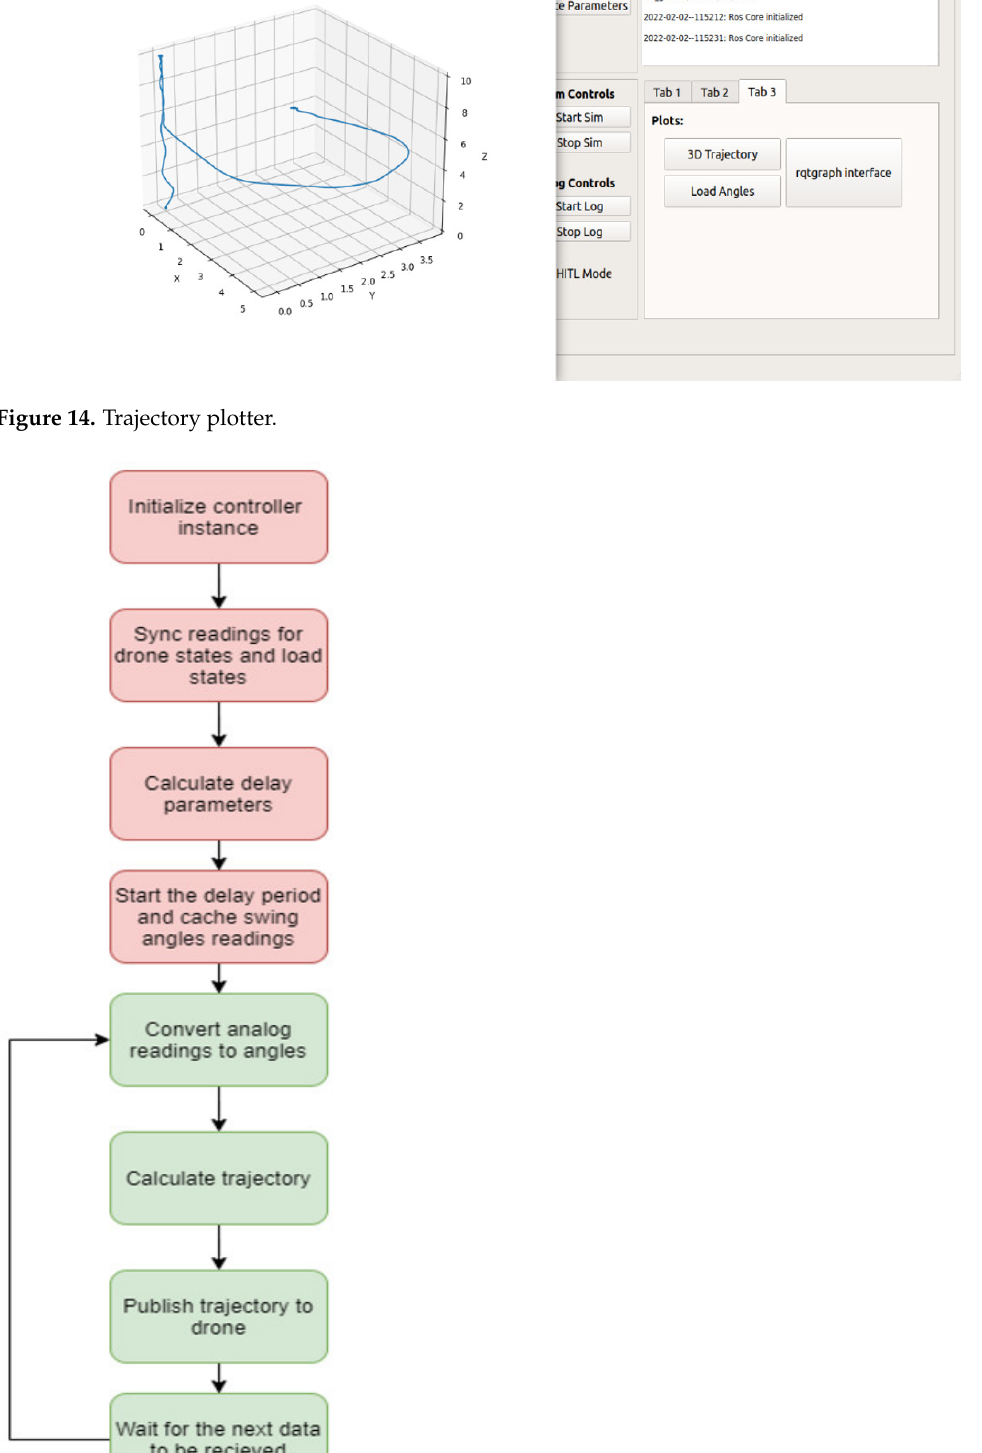
Figure 15. Controller code flowchart.